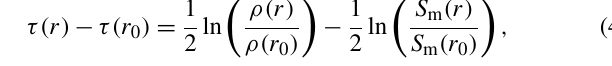
Figure 4. Sensitivity of T b as a function of six key radiative transfer parameters. The standard deviations (in units of K) are obtained by stochastically varying, with a sample size of 1000, the parameters of interest within the limits given in the Table